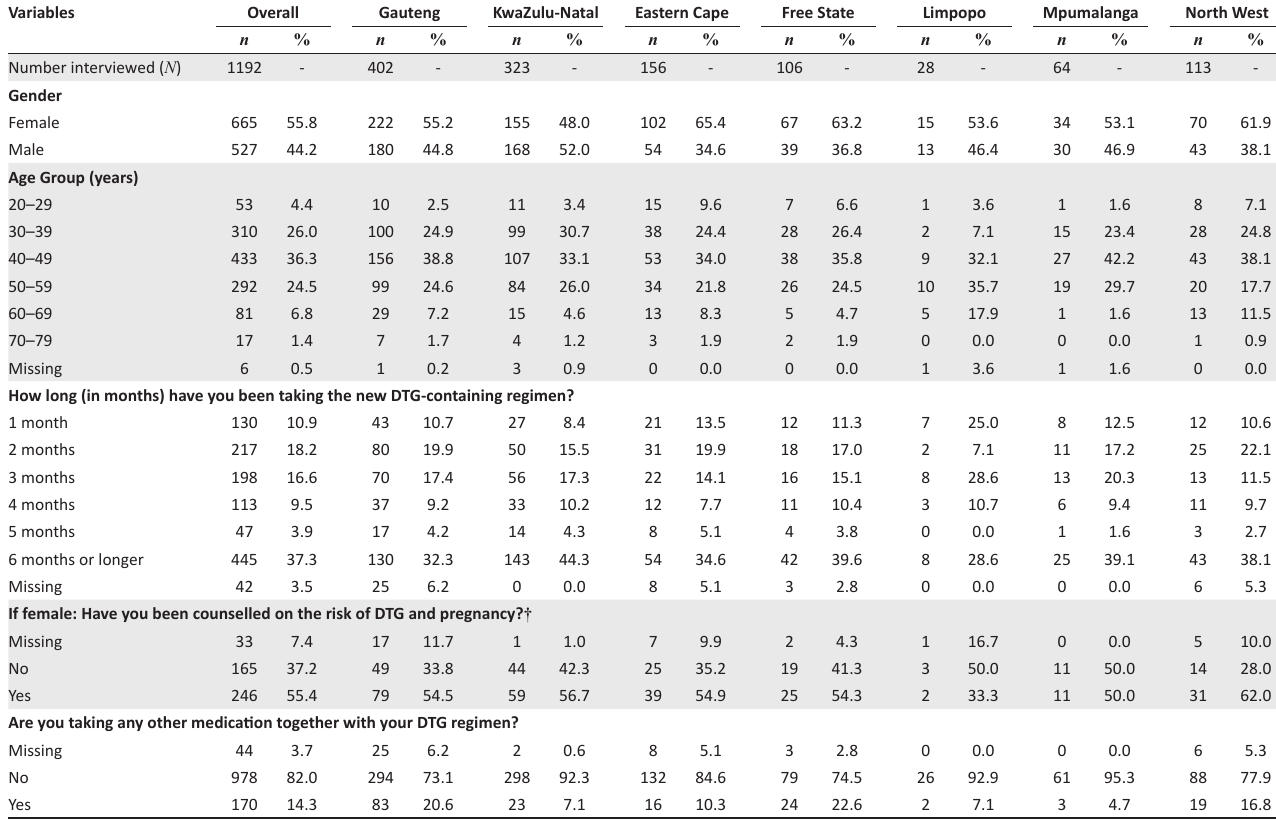
TABLE 1: Participant characteristics of patients on the tenofovir disoproxil fumarate/lamivudine/dolutegravir regimen.